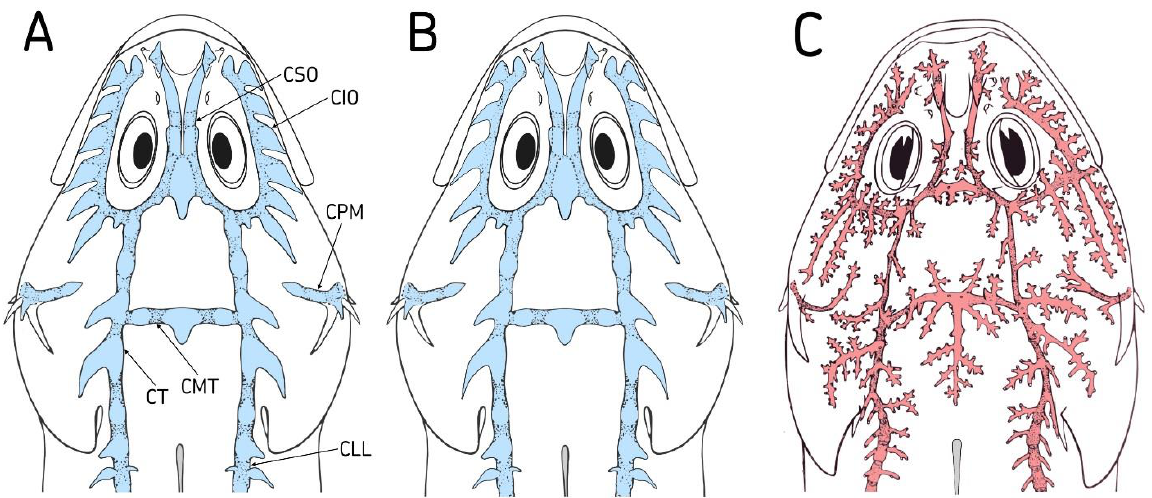
Figure 4. The lateral line systems on head: ( A ) T. quadricornis from the Baltic Sea; ( B ) Triglopsis sp. from the White Sea; ( C ) M. stelleri from the Japan Sea [7].